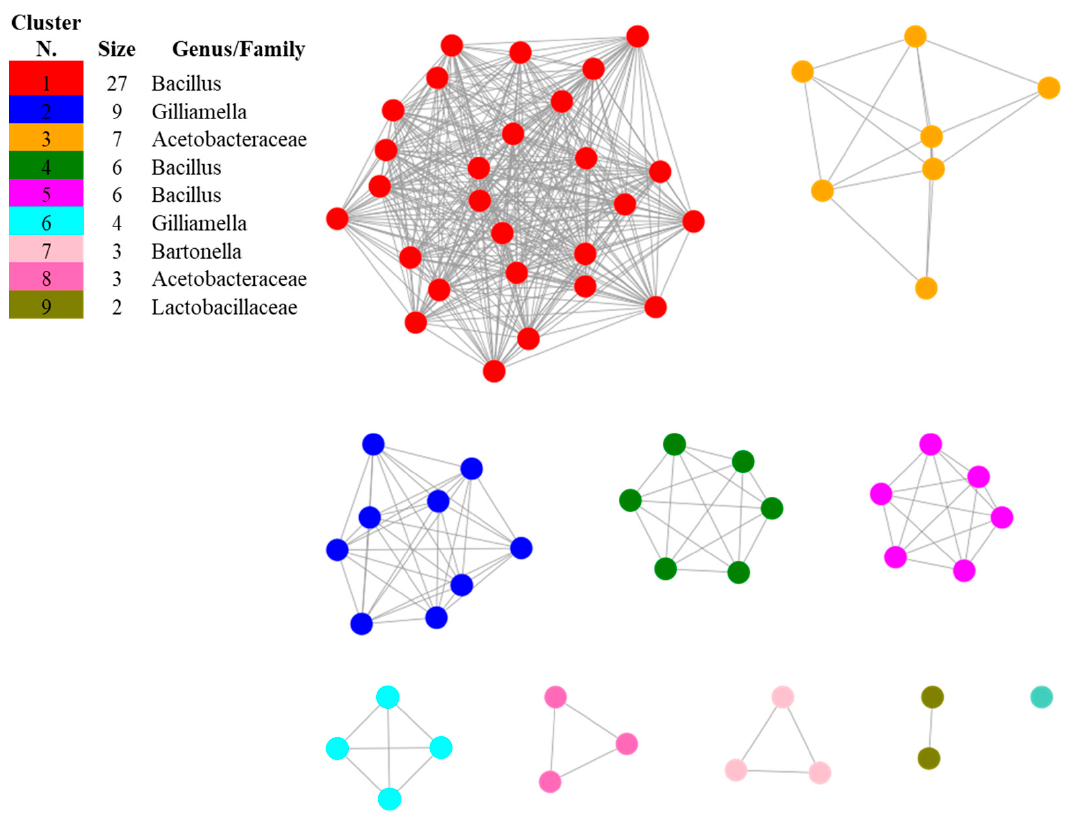
Figure 3. Sequence Similarity Network (SSN) showing the relationships among the protein sequences of putative homologs of methylketone synthase in bacterial species inhabiting apiaries. The most related proteins are grouped together in clusters. The singleton was constituted by the sequence of Lycopersicon hirsutum included in the dataset as the reference of a methylketone synthase described in plants. Table 2. List of potential methylketone homologs and their distribution in clusters, as calculated by the Sequence Similarity Network (SSN).